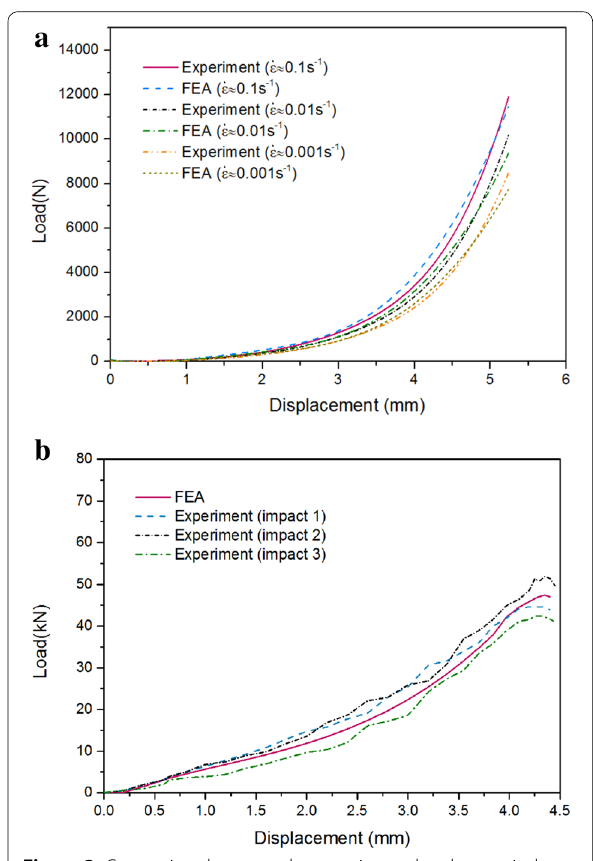
Figure 3 Comparison between the experimental and numerical results for ( a ) the quasi-static tests and ( b ) dynamic